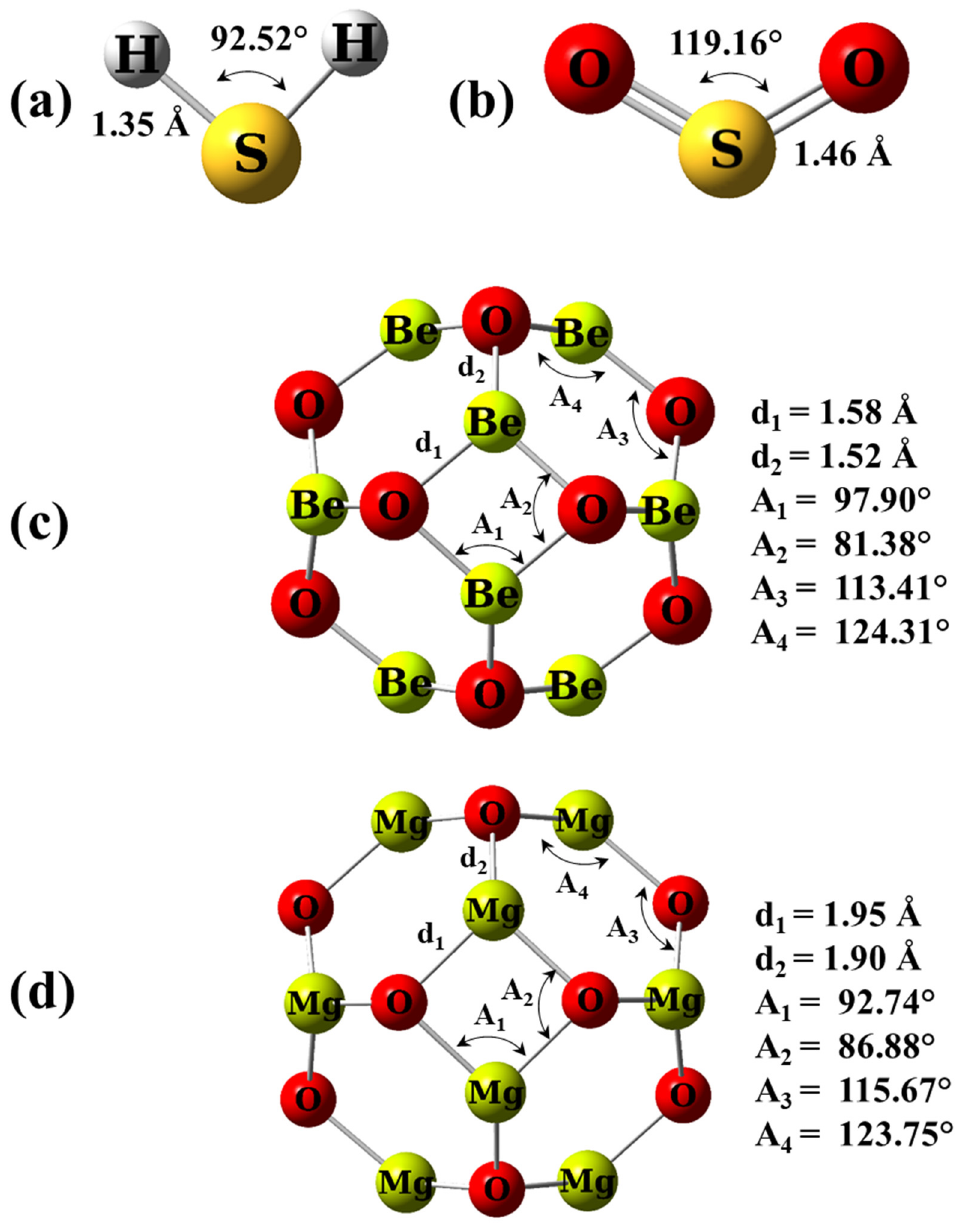
Figure 1. The optimized structures for ( a ) free H 2 S gas, ( b ) free SO 2 gas, ( c ) Be 12 O 12 , and ( d ) Mg 12 O 12 nano-cages.